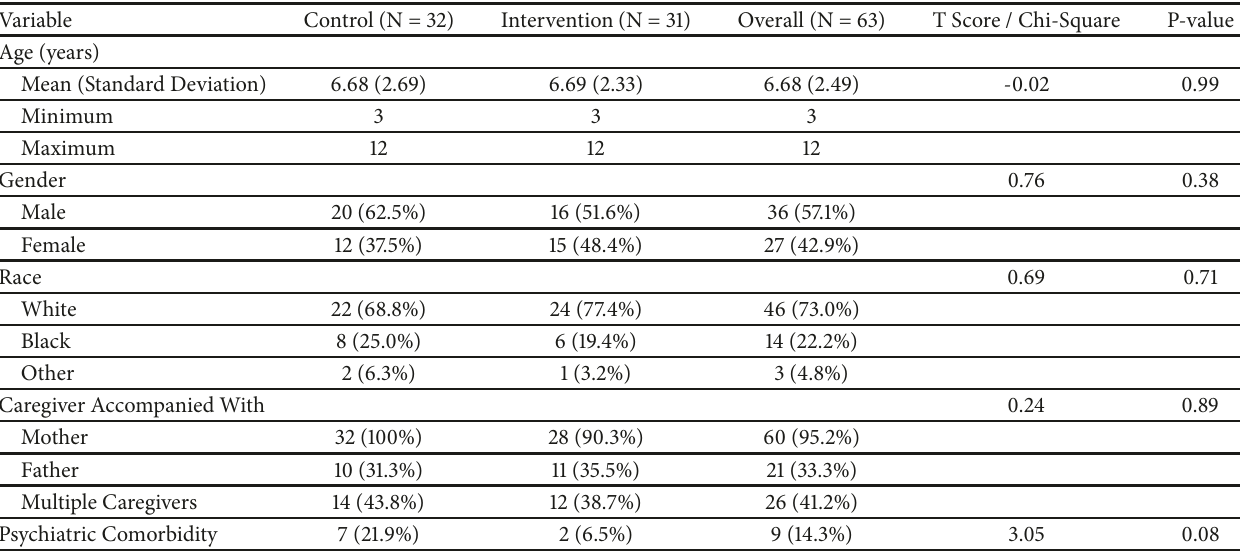
Table 1: Demographics and baseline characteristics.